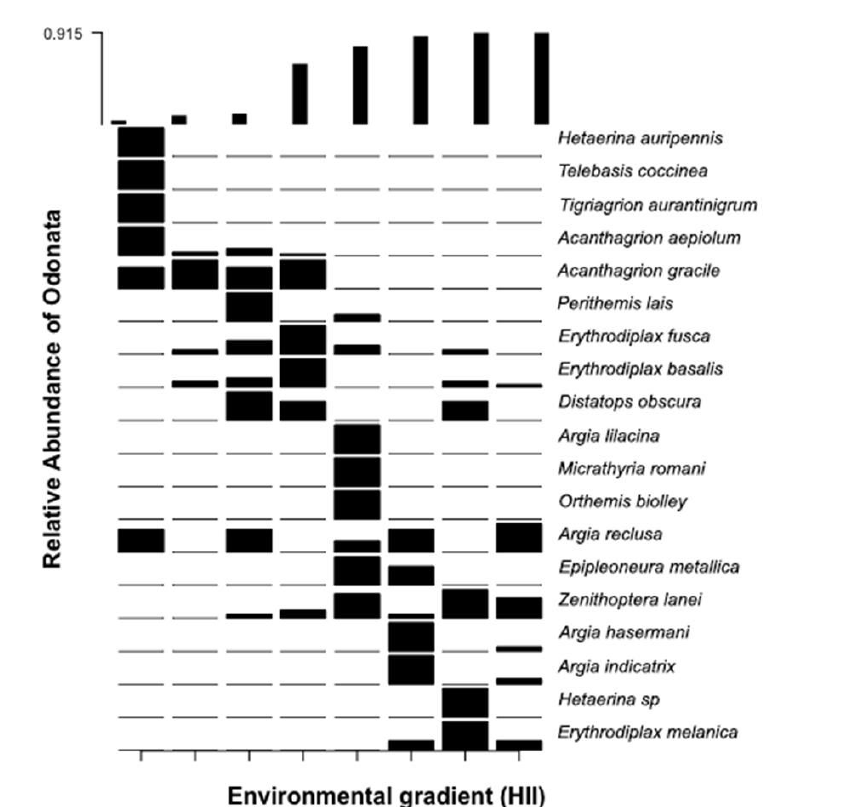
Figure 3. Distribution of the odonate community along the anthropogenic habitat gradient in the streams of Caxias, Maranhão,